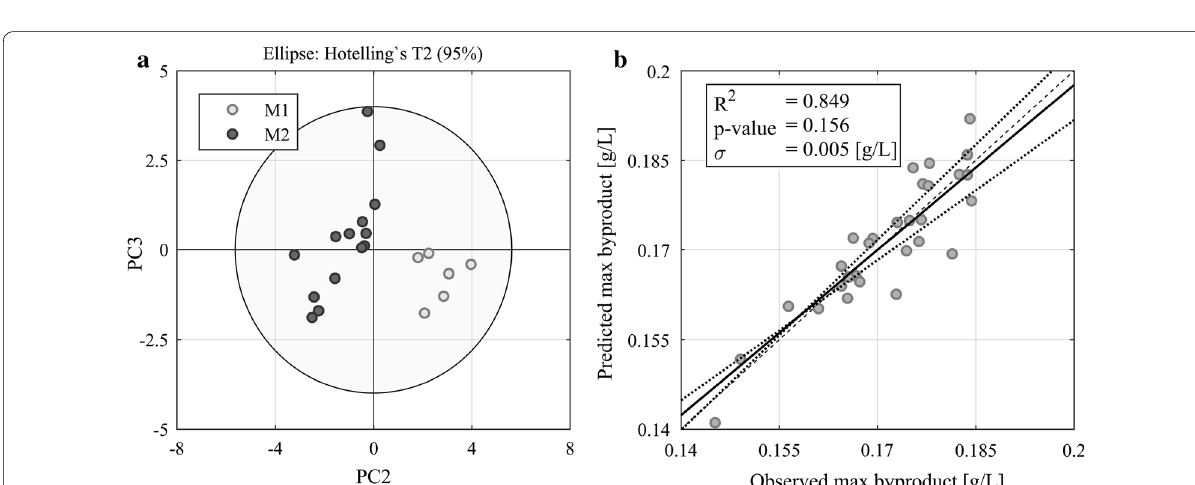
Fig. 2 PCA of FTIR spectra of crude SBO samples from different manufacturers resulted in 4 PCs (R2 0.999, cum 1.000). The score plot shows clustering according to manufacturer along PC 2 (plot a ). A PLS model of the specific composition of SBO and the byproduct resulted in 2 LVs (R2 0.29, 0.49) and showed some correlation between those variables. Hence, lot-to-lot variability of SBO seems to have an impact on process performance attributes (plot b ).